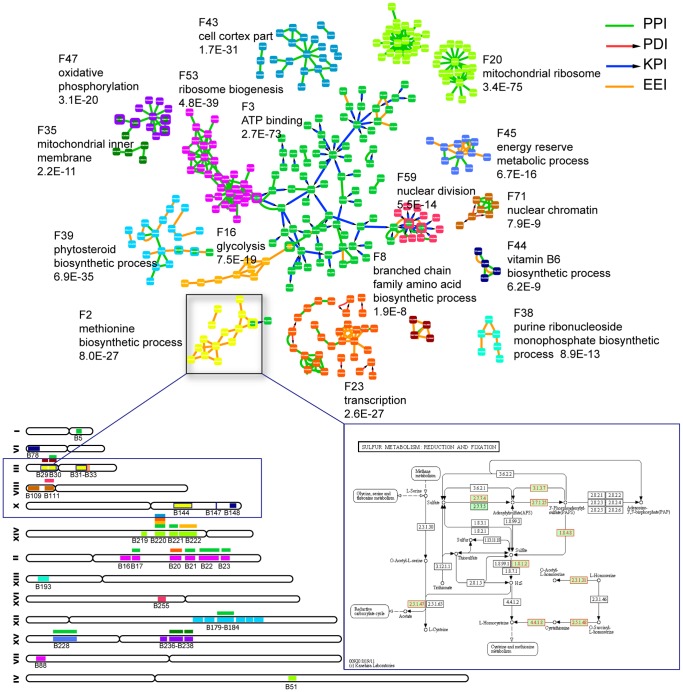
Biological features of the allele-specific sub-networks associated with LD blocks.A reconstructed network created by combining all of the allele-specific perturbed interactions associated with the 36 blocks and belonging to their enriched 16 functional groups. The genes belonging to different functional groups are marked with the same colors as in figure S3; also, chromosome blocks are marked using the same colors as their regulating functional classes. Functional annotation was conducted for each dyed gene module using DAVID based on GO and KEGG, and the most enriched functional item covering total genes (100%), along with its significance level (p-value), is presented near the dyed gene module. The gene module marked yellow is mainly associated with blocks on chromosome III (B29–B31) and X (B144); the lower right corner is a schematic representation of the metabolic pathway: sulfur metabolism, reduction and fixation, and nine enzymes in the module annotated to the pathway are marked with red rectangles.